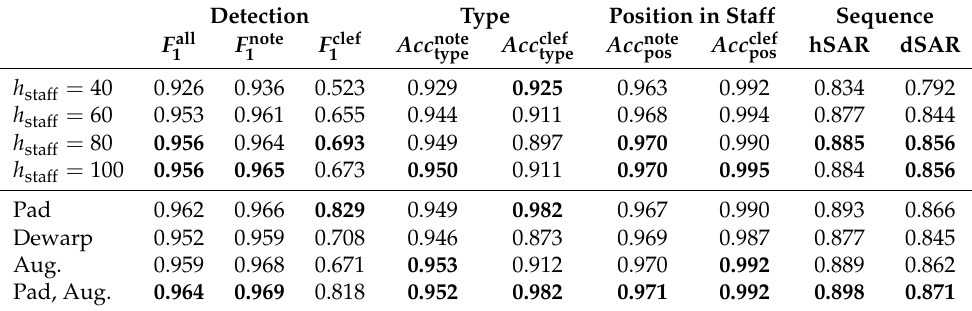
Table 6. Metrics of various hyperparameter settings for the symbol detection. All experiments were conducted using a cross-fold of size five using all available data. The best values for each metric are highlighted. Detection Type Position in